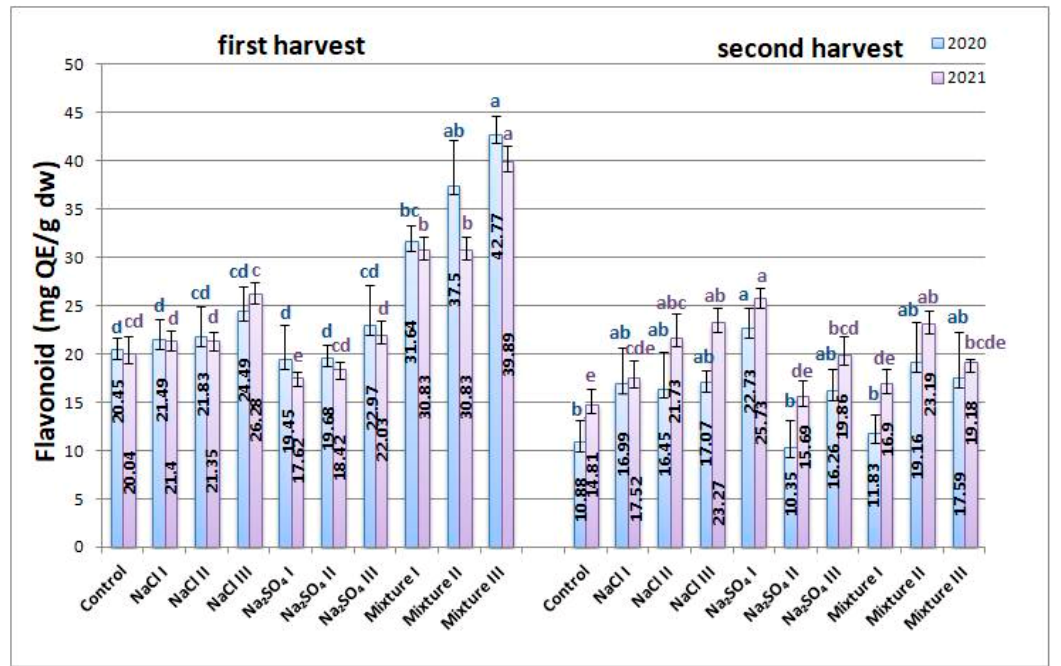
Figure 6. Average flavonoid content from Nepeta racemosa Lam. in 2020 and 2021, with significant differences at 0.05 level indicated with letters.